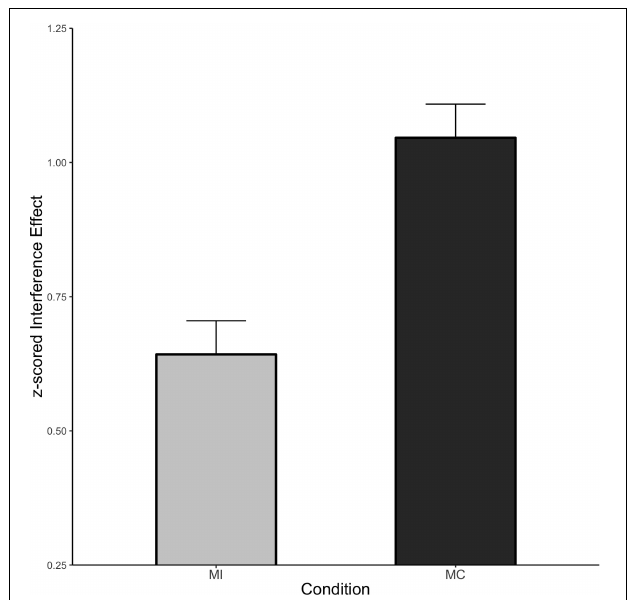
FIGURE 6 | ISPC effect in Experiment 3. Error bars represent the 95% HDI.